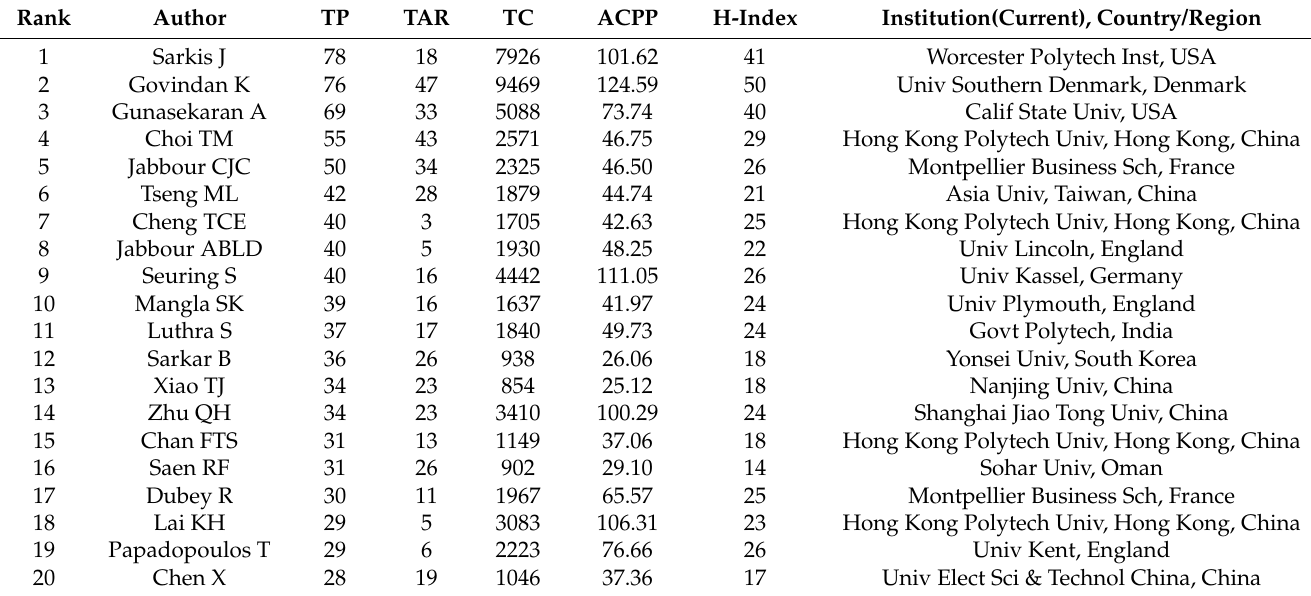
Table 5. Contribution of the top 20 authors in SCM.